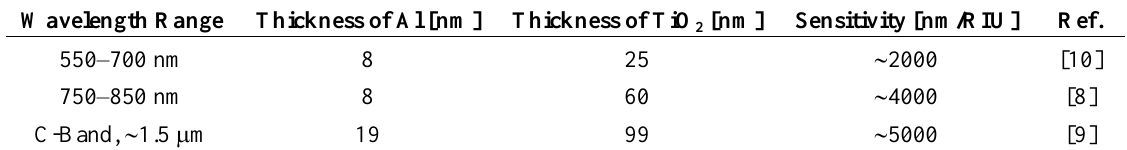
( a ) ( b ) Table 1. Summary of SPR sensors based on DLUWTs for different spectral regions (table originally published in [10], © 2014, reproduced with permission from Elsevier). Wavelength Range Thickness of Al [nm] Thickness of TiO [nm] Sensitivity [nm/RIU] 2